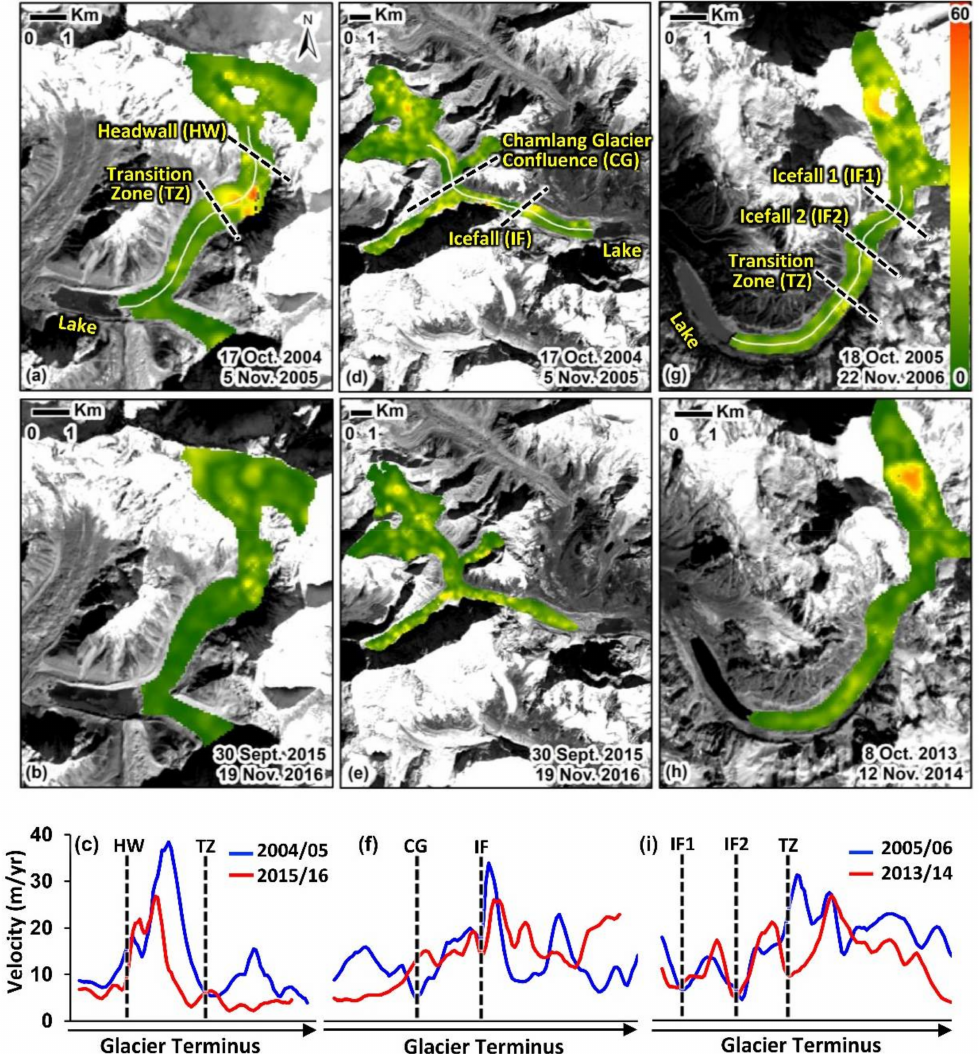
Figure 8. Displacement maps (m/year) and two-point boxcar average velocity measured along the centerline of ( a – c ) Imja and Lhotse Shar Glaciers, ( d – f ) Lower Barun Glacier, and ( g – i ) Thulagi Glacier. Headwall (HW), transition zone (TZ), Chamlang Glacier Confluence (CG), icefall (IF), icefall-1 (IF1), and icefall-2 (IF2) represent markers where a change in flow speed was